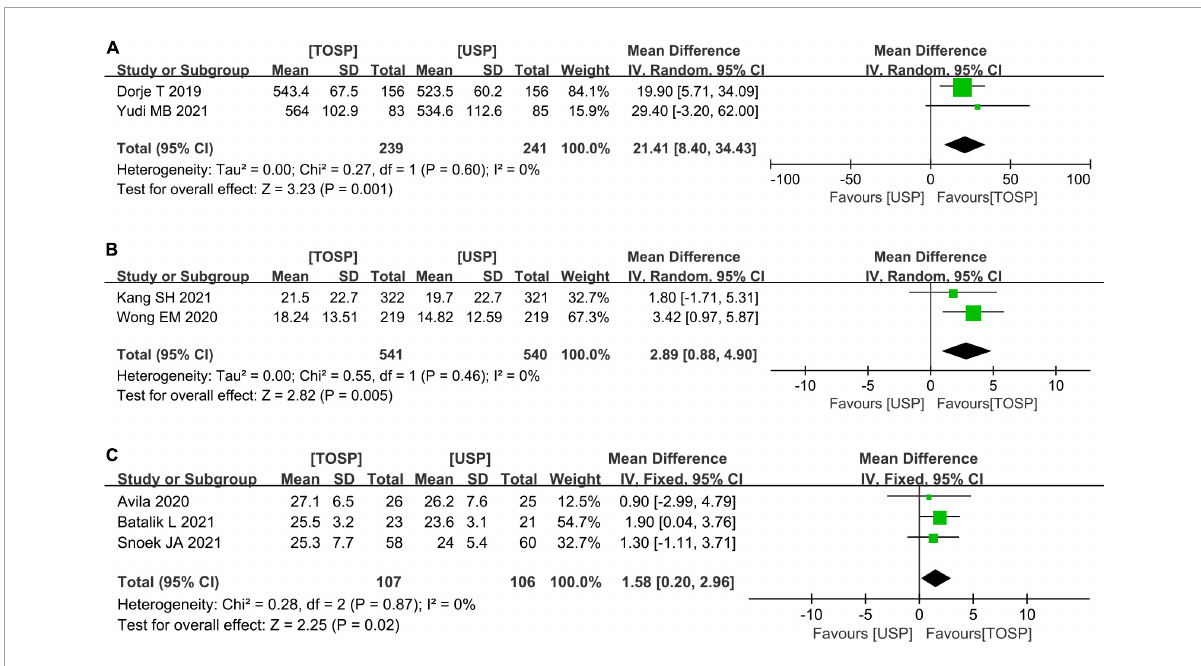
FIGURE4 Forest plots of the effects of telemedicine on physical activity and exercise— (A) 6MWT; (B) GSLTPA score; (C) VO 2 Peak (mL · kg − 1 · min − 1 ); TOSP, telemedicine of secondary prevention; USP, usual secondary